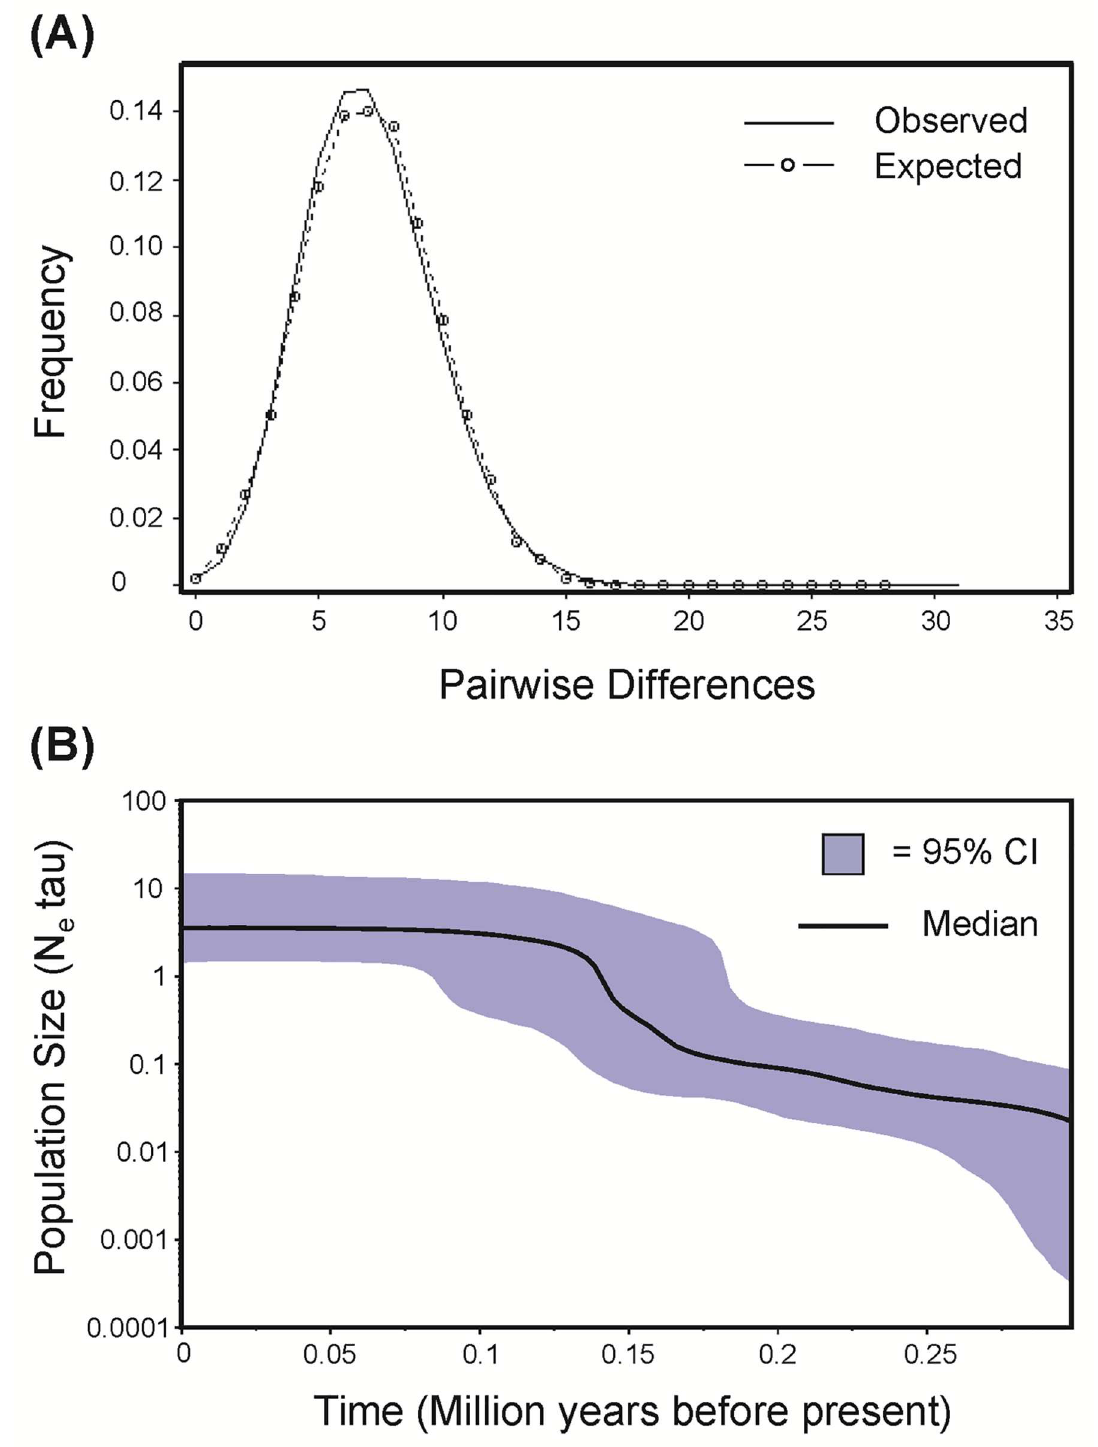
Fig 4. Assessments of Historical Population Growth for Exocoetus volitans . ( A ) Mismatch distribution of cytochrome b sequencedata for all individuals (n = 266) generatedusing Arlequin, v.3.5 [16] and DNAsp, v.5 [12]. Solid lines indicate observed frequencies of pairwise differences and dashedlines with circles indicate expected frequencies of pairwise differences. ( B ) Bayesian skyline plot of all cytochrome b sequencesgeneratedusing BEAST, v.1.6.1 [25]. The solid